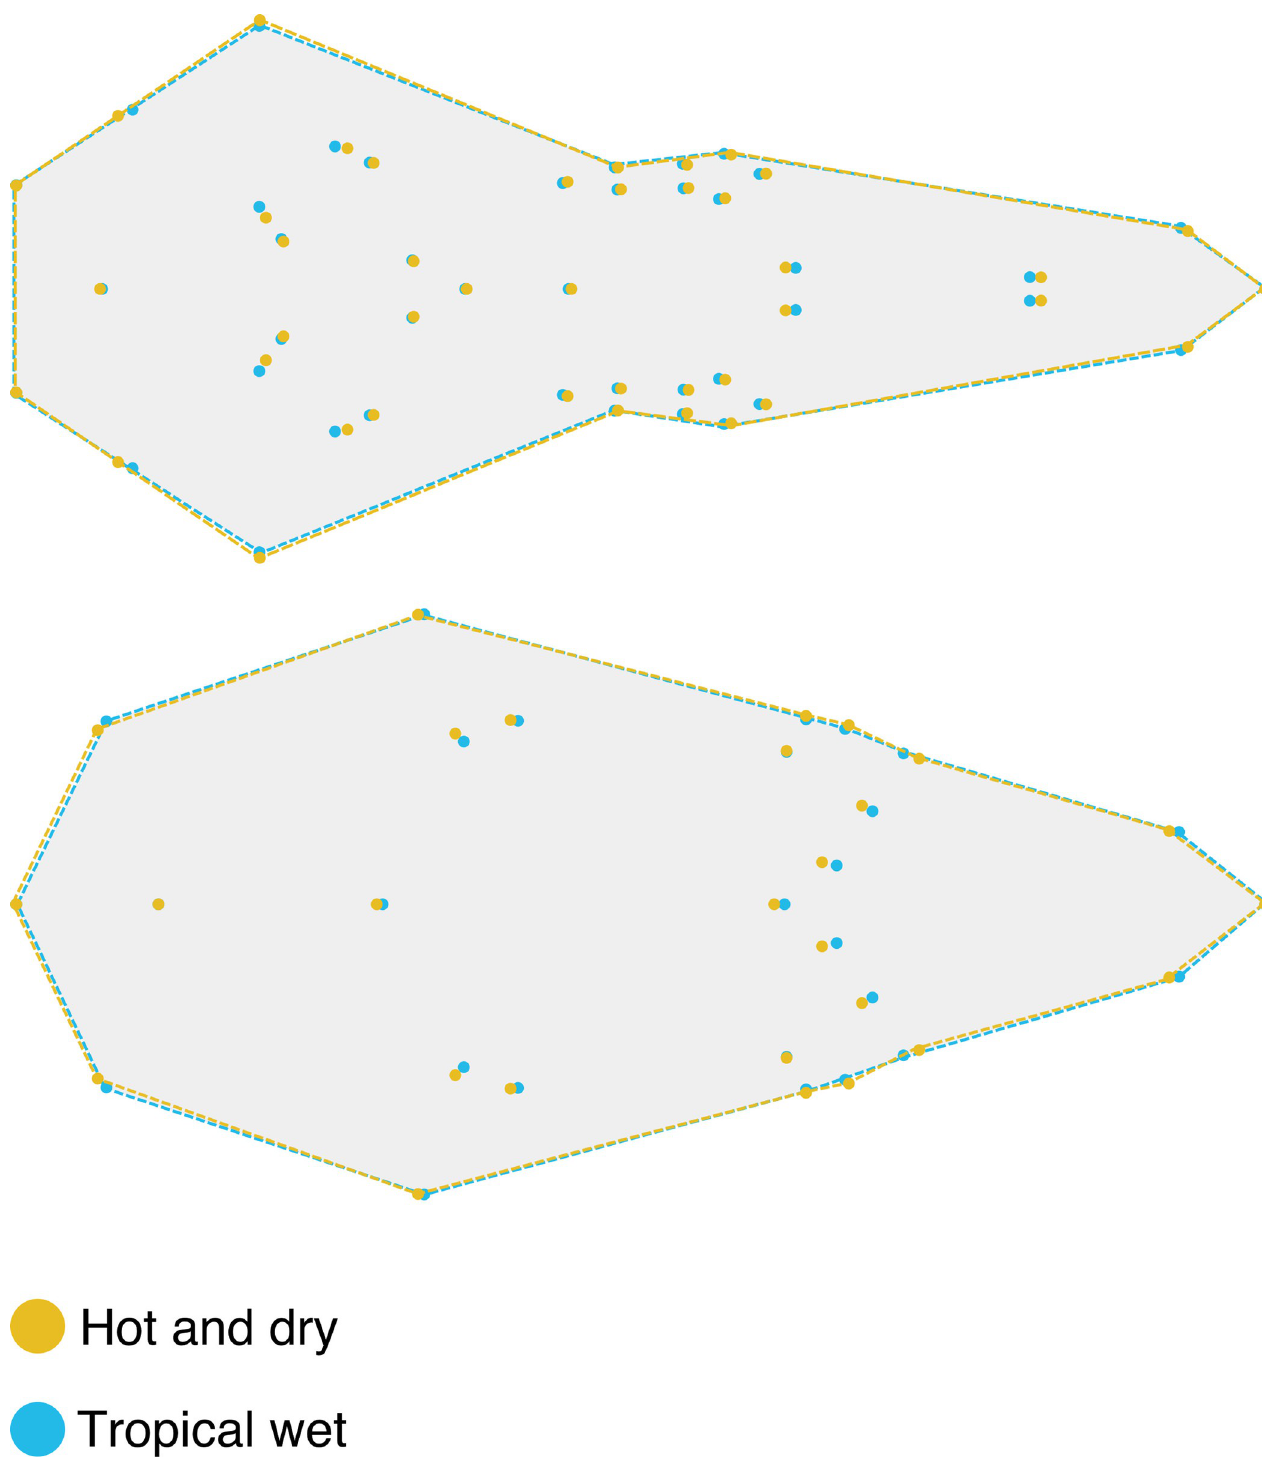
Fig 4. Significant shape changes related to climate. Top: ventral shape; bottom: dorsal shape.